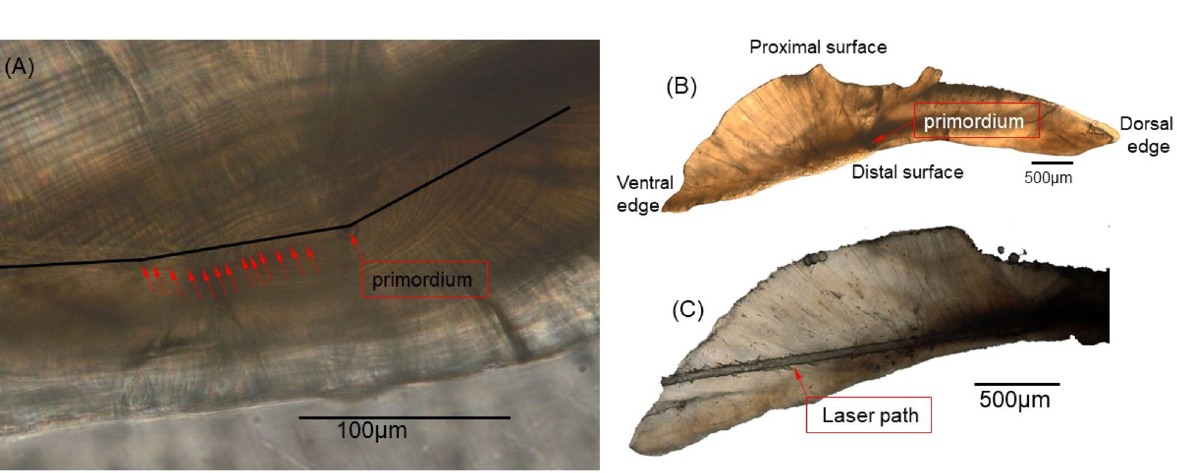
Figure 3. Polished otolith section of Eleutheronema tetradactylum . ( A ) Otolith section photograph reveal the primordium, red arrows indicate the daily increments, the black line indicates the center of the laser ablation path; ( B ) Complete graph of transverse section of a E. tetradactylum otolith; ( C ) The laser path on the otolith